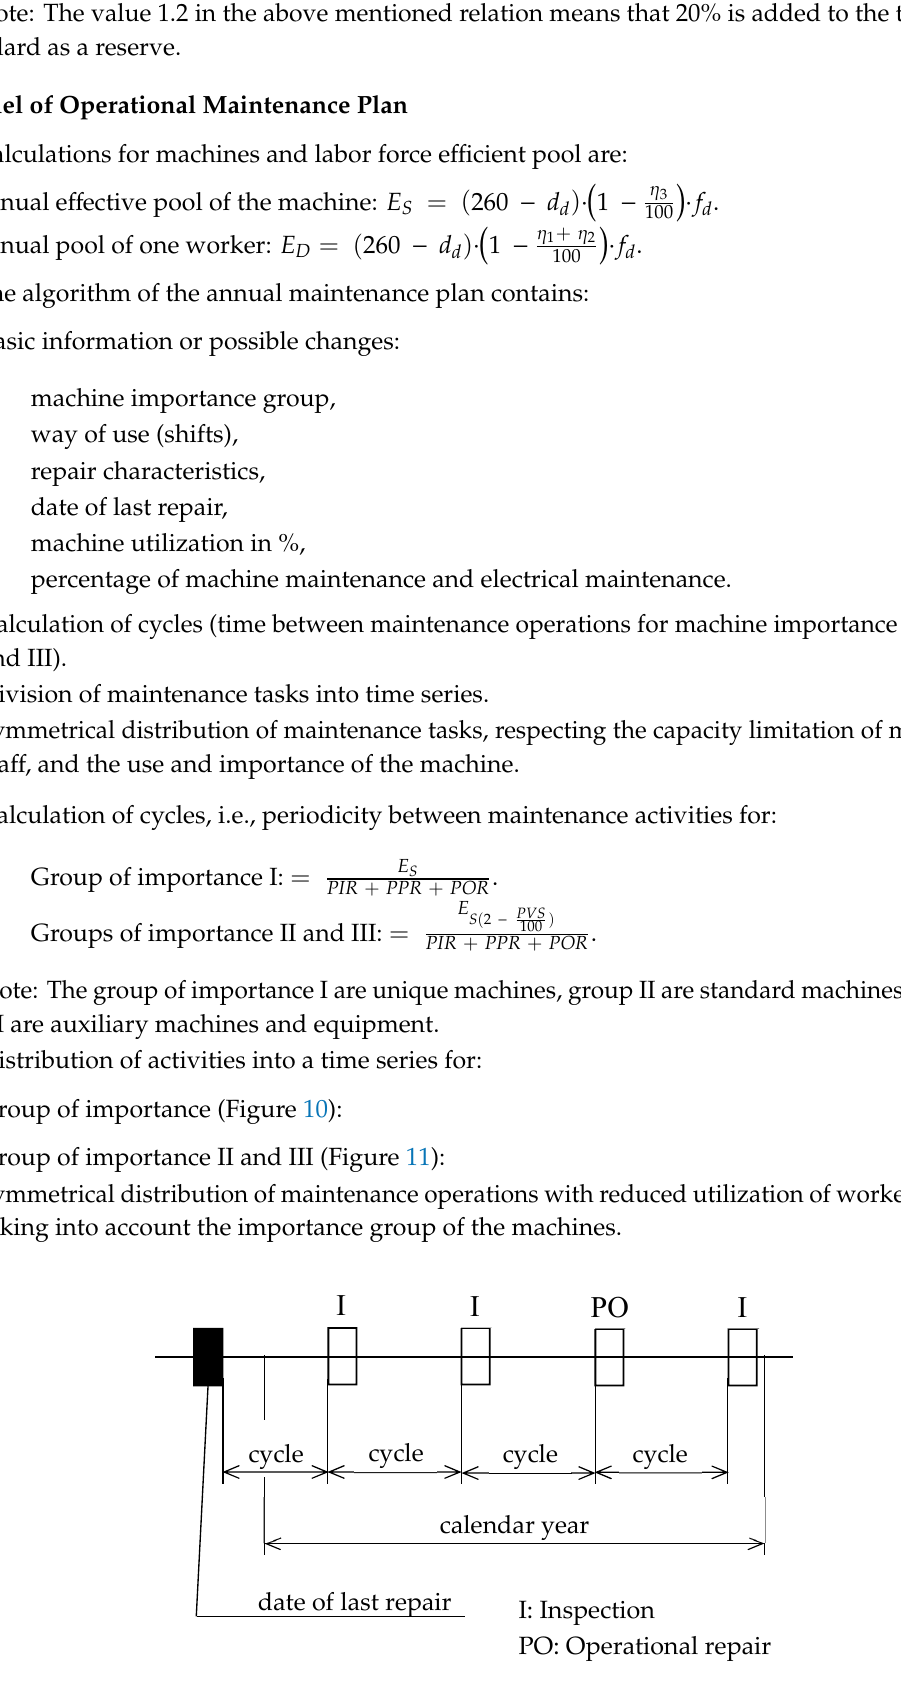
Figure 11. Annual maintenance plan for group of importance II and III 3.